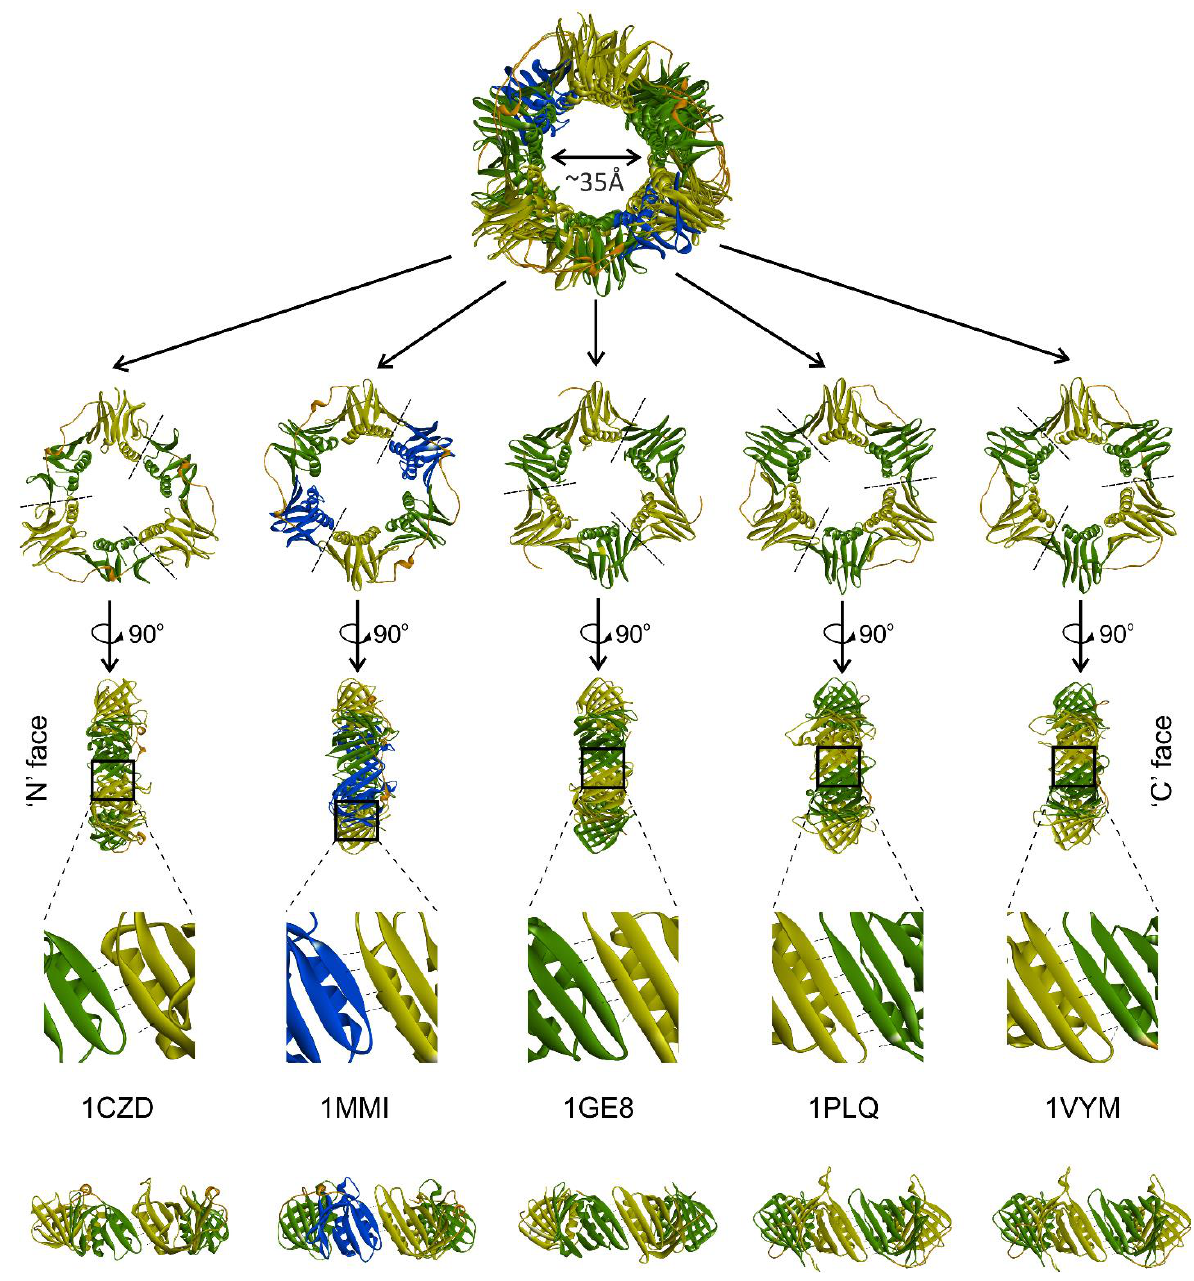
Figure 2. Sliding clamps from different organisms. Sliding clamp from T4 bacteriophage gp45 (1CZD), E. coli β clamp (1MMI), Pyrococcus furiosus PCNA (1GE8), Saccharomyces cerevisiae PCNA (1PLQ), and Homo sapiens PCNA (1VYM) are superimposed using PyMol. In the dimeric bacterial clamp (1MMI), three domains are colored in blue (I), green (II), and yellow (III), while in trimeric clamps, NTD is colored green and CTD, yellow; the IDLC is colored orange. The ‘N’ and ‘C’ faces of the clamps are shown. The enlarged subunit – subunit interface and hydrogen bonds are shown at the bottom of the figure.